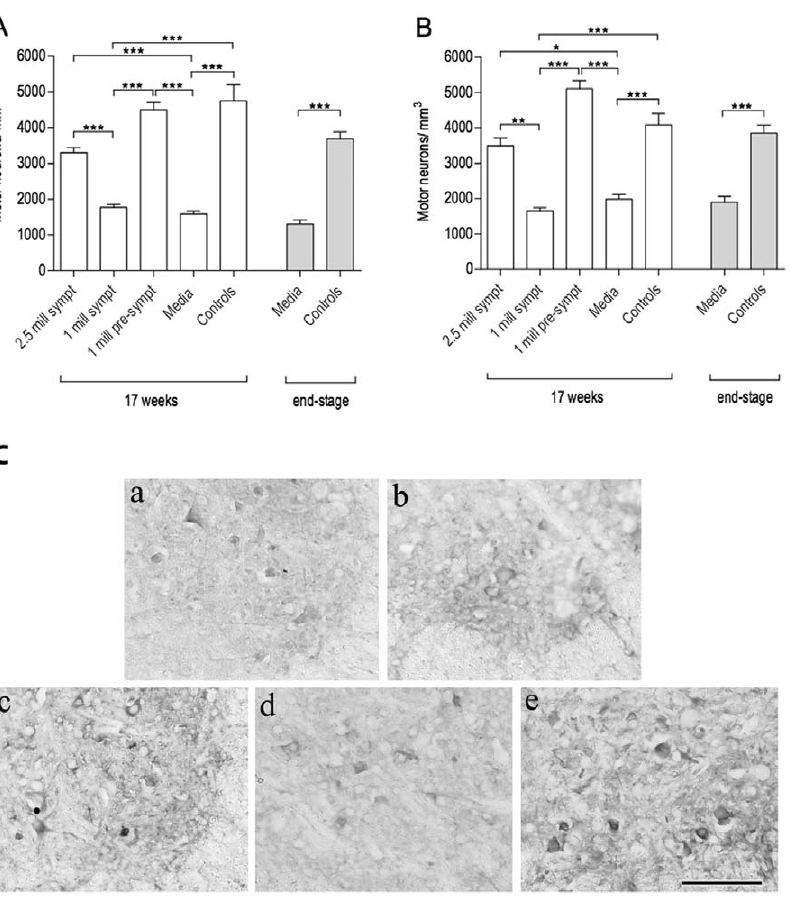
Figure 5. Characteristics of motor neuron survival in the spinal cord of G93A mice. Motor neuron counts were performed in the cervical ( A ) and lumbar ( B ) ventral horns of G93A mice at 17 weeks of age and at end-stage of disease. Mice receiving 2.5 6 10 6 cells symptomatically ( Gr 1 ) or 1 6 10 6 cells pre-symptomatically ( Gr 3 ) had significantly higher motor neuron densities than the Media group ( Gr 4 ) at 17 weeks of age or at end- stage of disease. In both cervical and lumbar spinal cords, motor neuron densities between Gr 2 (1 6 10 6 cells, symptomatic) and Media-injected ( Gr 4